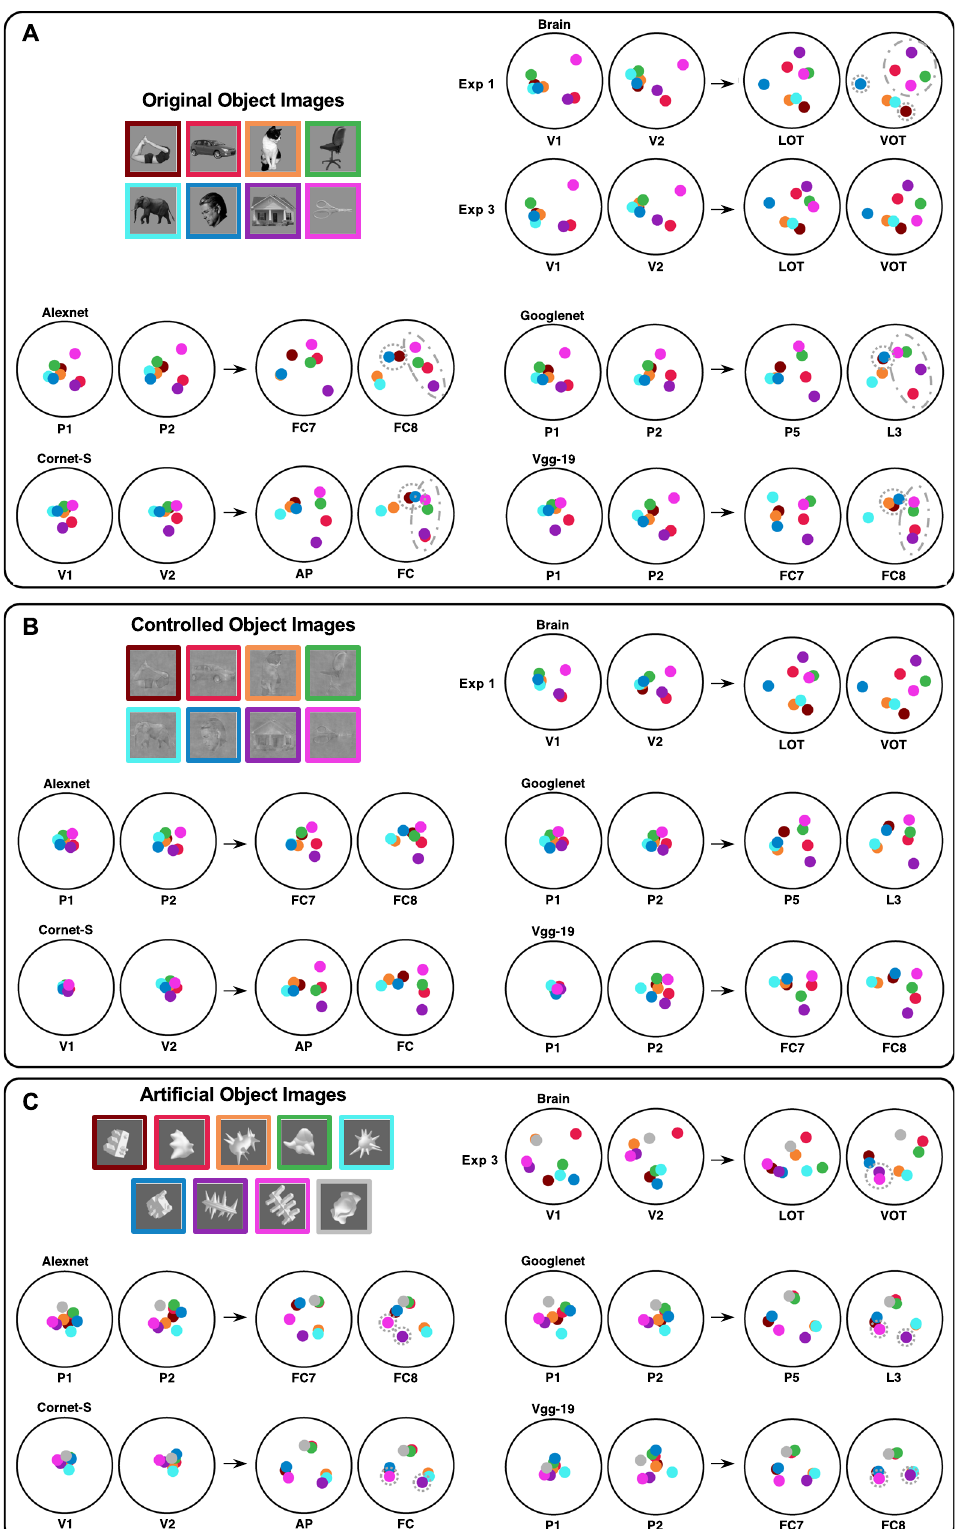
tracking high-level processing of the real-world objects even when category-selective voxels were removed was due to interactions between category-selective and non-selective brain regions. With the arti fi cial visual stimuli, however, no preexisting category information, semantic knowledge, as well as experience with the stimuli could affect visual processing at a higher level. This